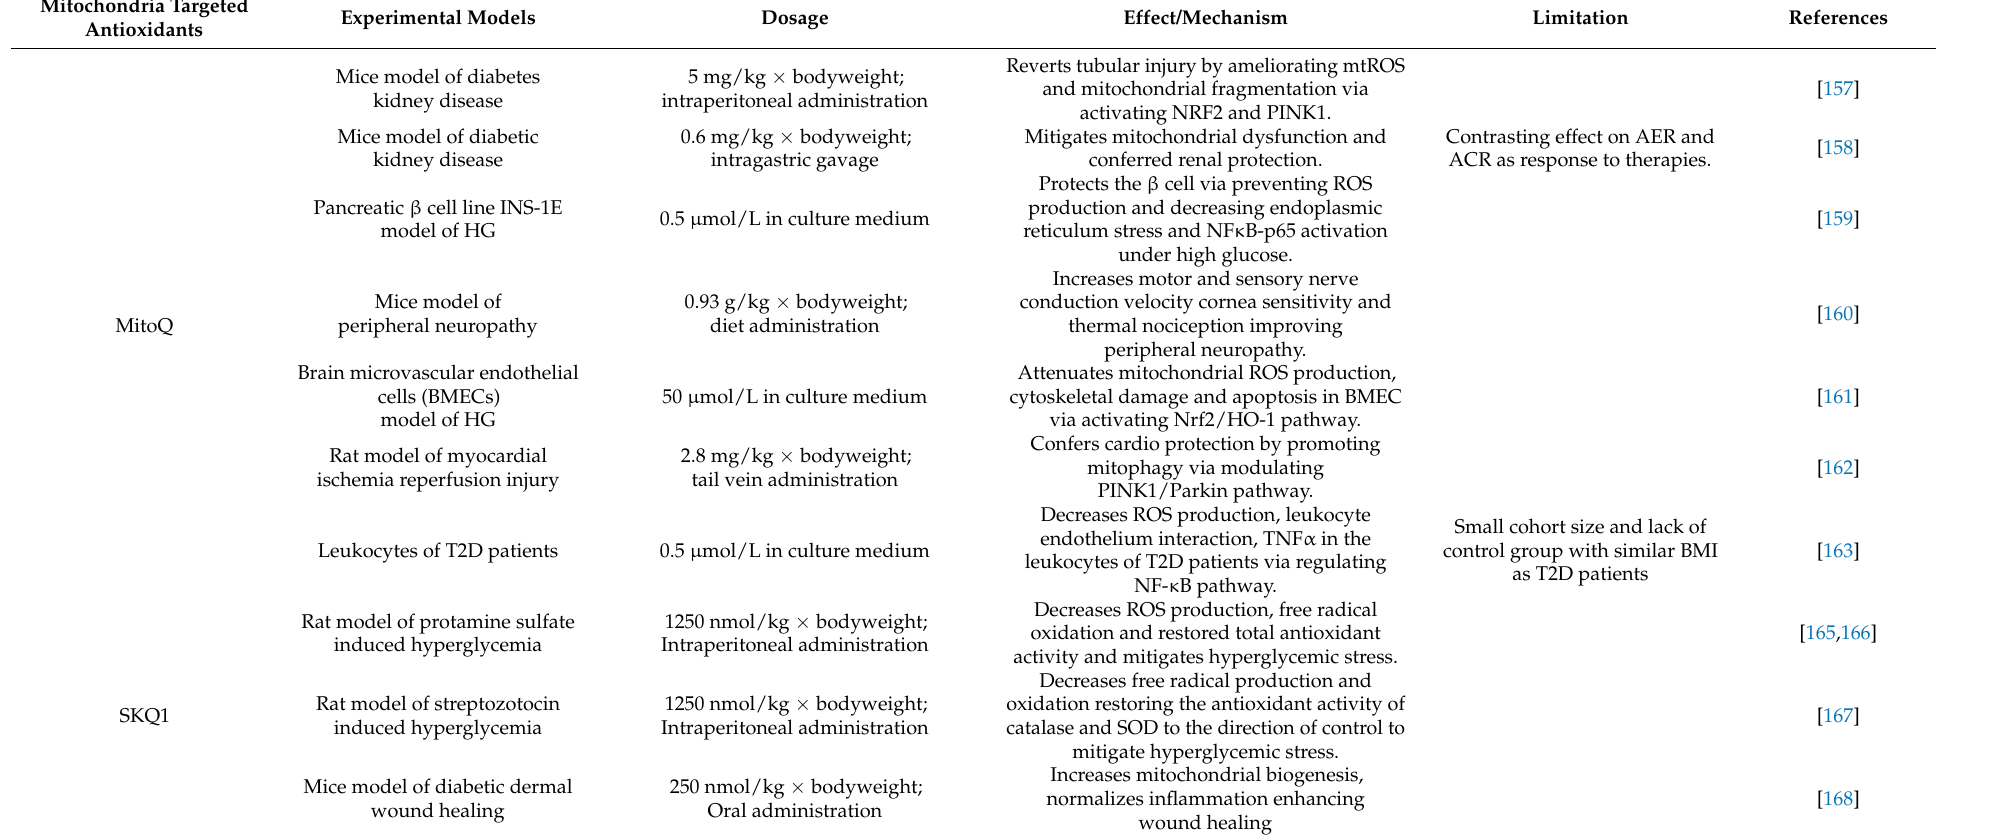
Table 3. Mitochondrial targeted antioxidants in different diabetic